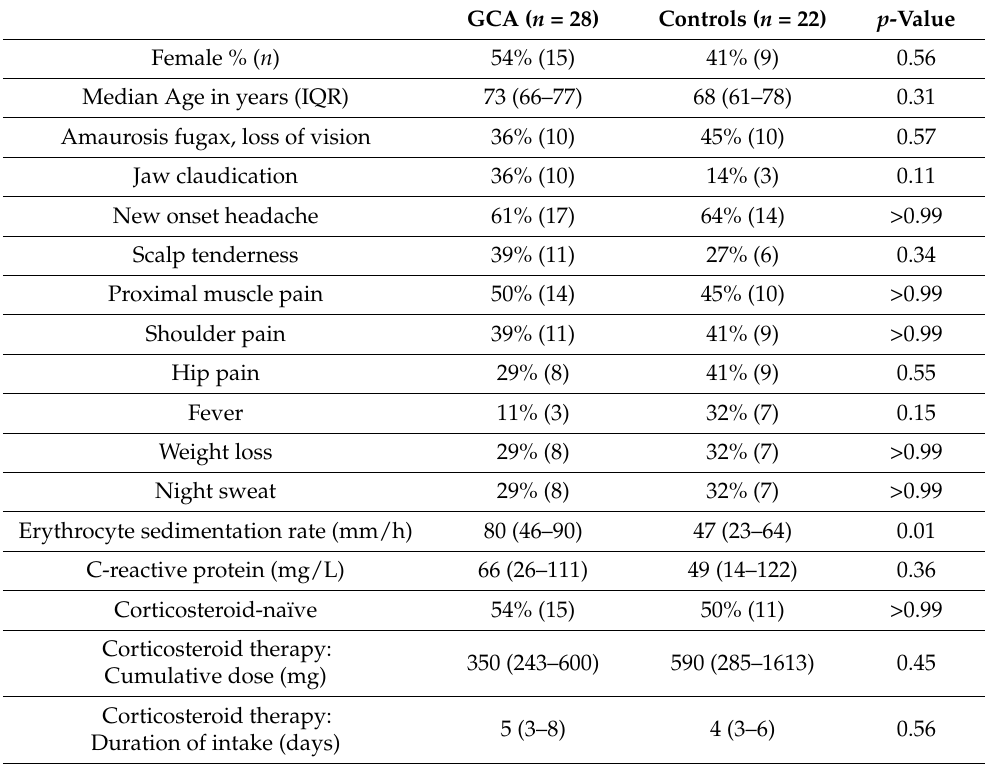
Table 1. Patients characteristics: Data are expressed as percentages (numbers) or median (interquartile range). GCA = giant cell